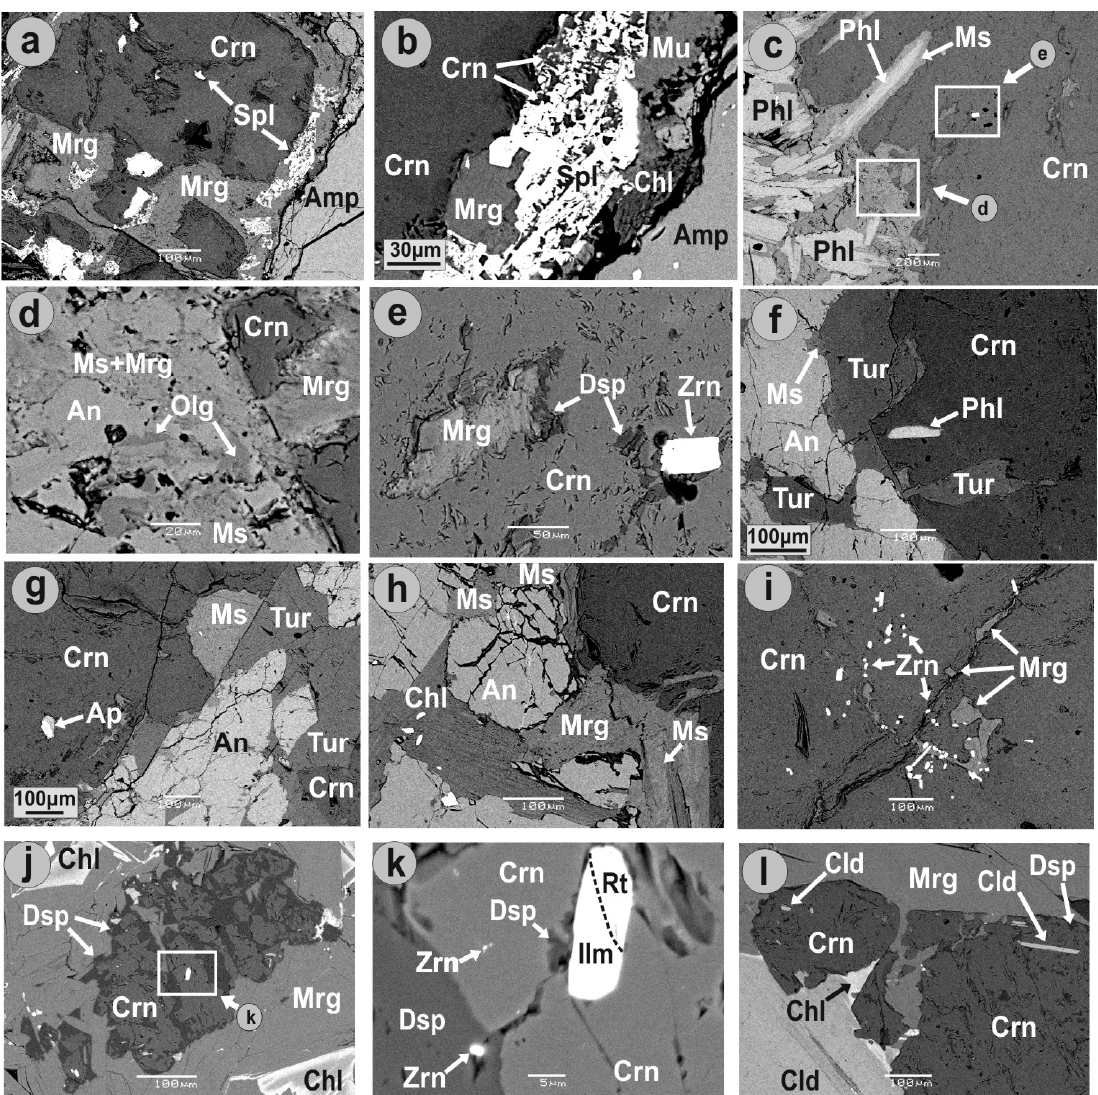
Figure 5. Microphotographs (SEM-BSE images) demonstrating mineralogical assemblages of corundum-bearing assemblages from Greece. ( a , b ) Ruby (Crn) including and rimmed by chromian spinel (Spl), margarite (Mrg), muscovite (Mu), chlorite (Chl) and pargasitic hornblende (Amp) (sample Dr1, Paranesti/Drama); ( c , d ) Blue sapphire (Crn) in association with anorthite (An) and phlogopite (Phl) replaced by muscovite (Mus), margarite (Mrg), and oligoclase (Olg) (Naxos island, sample Nx1); ( e ) Zircon (Zrn) is included in sapphire, diaspore (Dsp) and margarite (Mrg) fill fractures and are retrograde minerals. Naxos island, sample Nx1); ( f , g ) Blue sapphire including phlogopite and fluorite (Fl) is associated with anorthite (An) and replaced by tourmaline (Tur) and muscovite (Mus) (Naxos island, sample Nx4); ( h ) Blue sapphire and anorthite are rimmed by muscovite, margarite and chlorite (Chl) the late probably replacing phlogopite (Naxos island, sample Nx4a); ( i ) Blue sapphire including zircon is replaced by margarite (Naxos island, sample Nx4a); ( j – l ) Blue sapphire associated with margarite includes and replaces chloritoid (Cld) and are retrogressed to diaspore and chlorite, respectively. Zircon and Ilmenite (Ilm), rutile (Rt) are included in corundum (Ikaria island, sample Ik2).